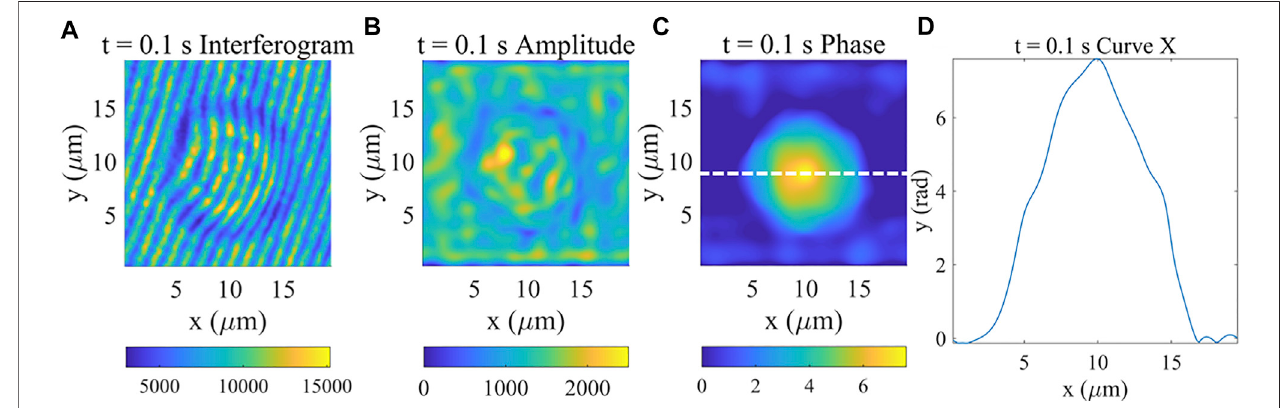
FIGURE2| Complex fi eldandPhasemeasurement resultsofpolystyrenemicrospheres. (A) Interferogram imageat0.1 s. (B) Amplitude imageat0.1 s. (C) Phase image at 0.1 s. (D) Phase pro fi le of horizontal direction curves at the location indicated by the white dashed line shown in (C) .